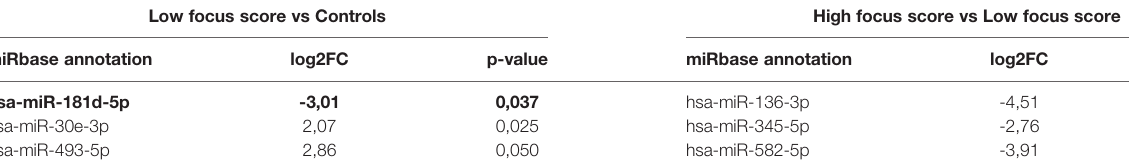
TABLE 2 | miRNAs differentially expressed in labial salivary glands from control subjects and SS-patients with low or high focus score. Low focus score vs Controls